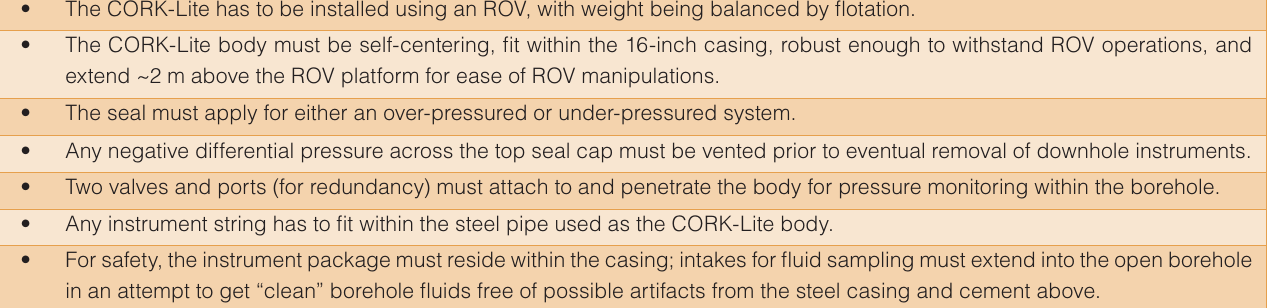
Table 1. A list of design consideration of CORK-Lite. (cid:116)(cid:1)